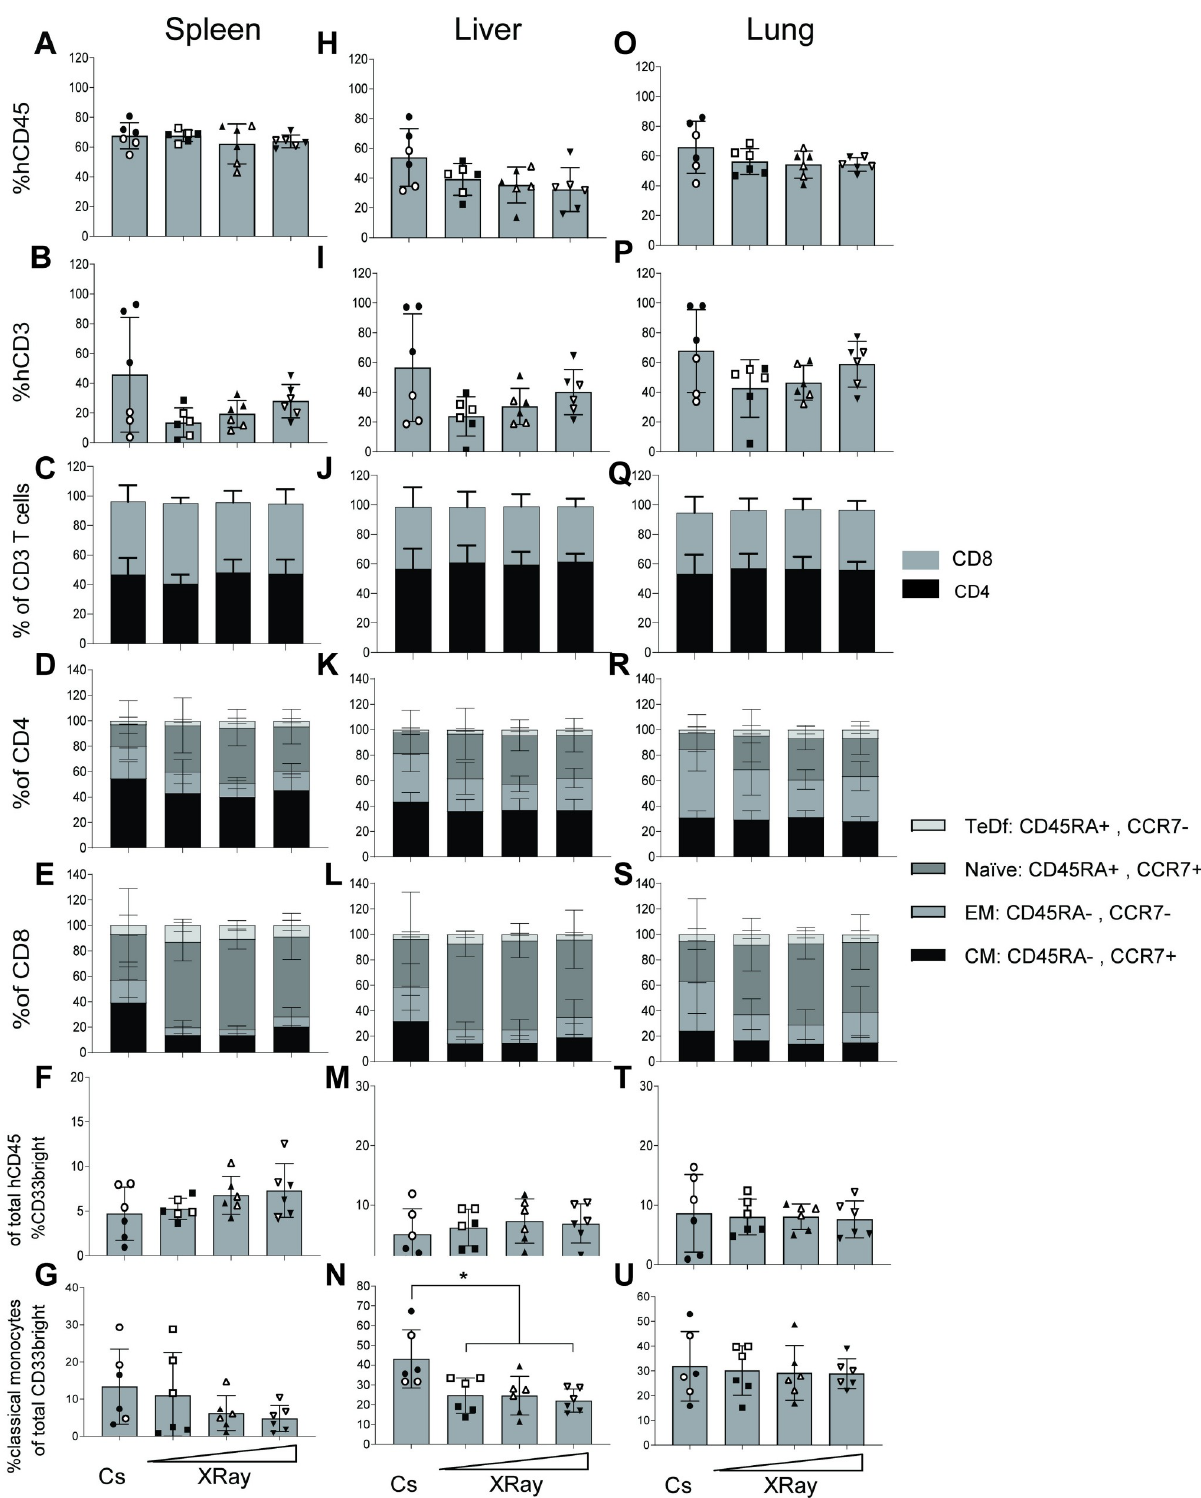
Fig 5. Human cell engraftment in inducer and effector tissues, spleen, liver, lung. (A+H+O) Bar graph for each irradiation group showing the percentage of human cells based on expression of hCD45 out of total WBCs identified in a forward/side-scatter flow cytometry gating plot in spleen, liver and lung, respectively. (B+I+P) Bar graph of the frequencies of human T cells based on expression of surface hCD3 in spleen, liver and lungs,